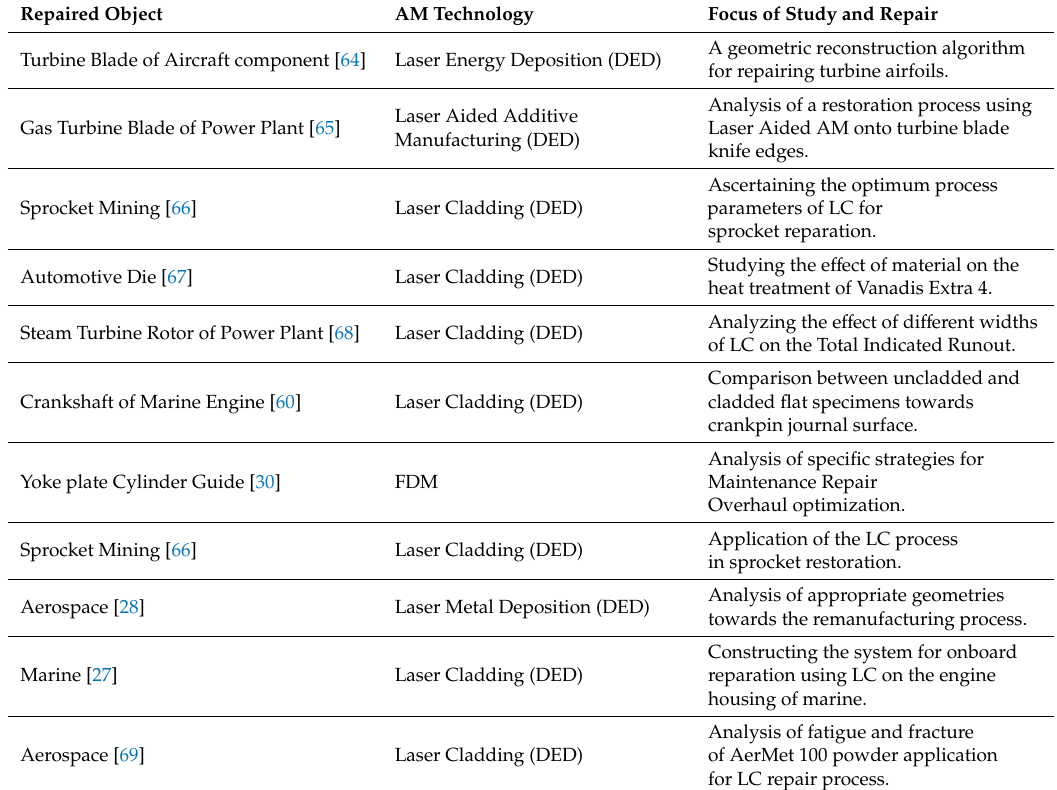
Table 5. Focus of previous research in AM Table 5 . Focus of previous research in AM reparation.